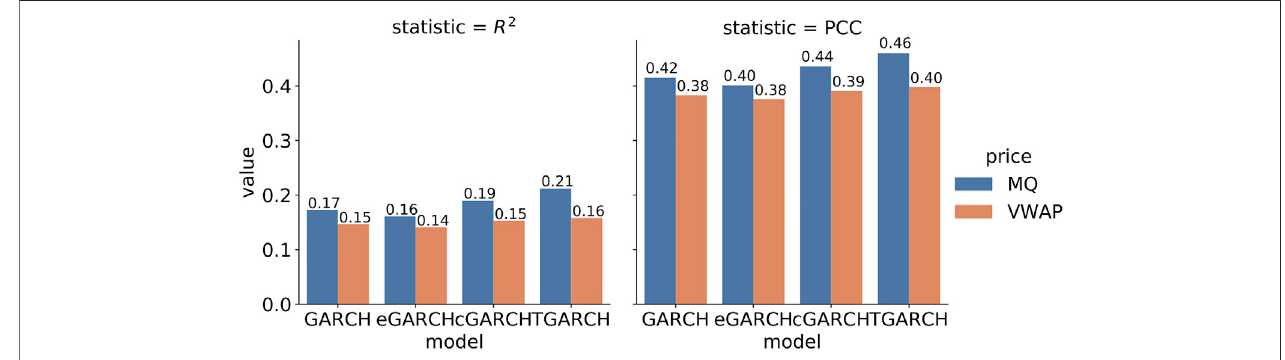
FIGURE6| Resultsofout-of-samplelikelihoodratiotest.In-sampleconsistsof50,000pointsandout-of-sampleconsistsof8,000points.*Bluepaletterepresents the p -value smaller than 0.001. NaN — some algorithms had convergence problems.